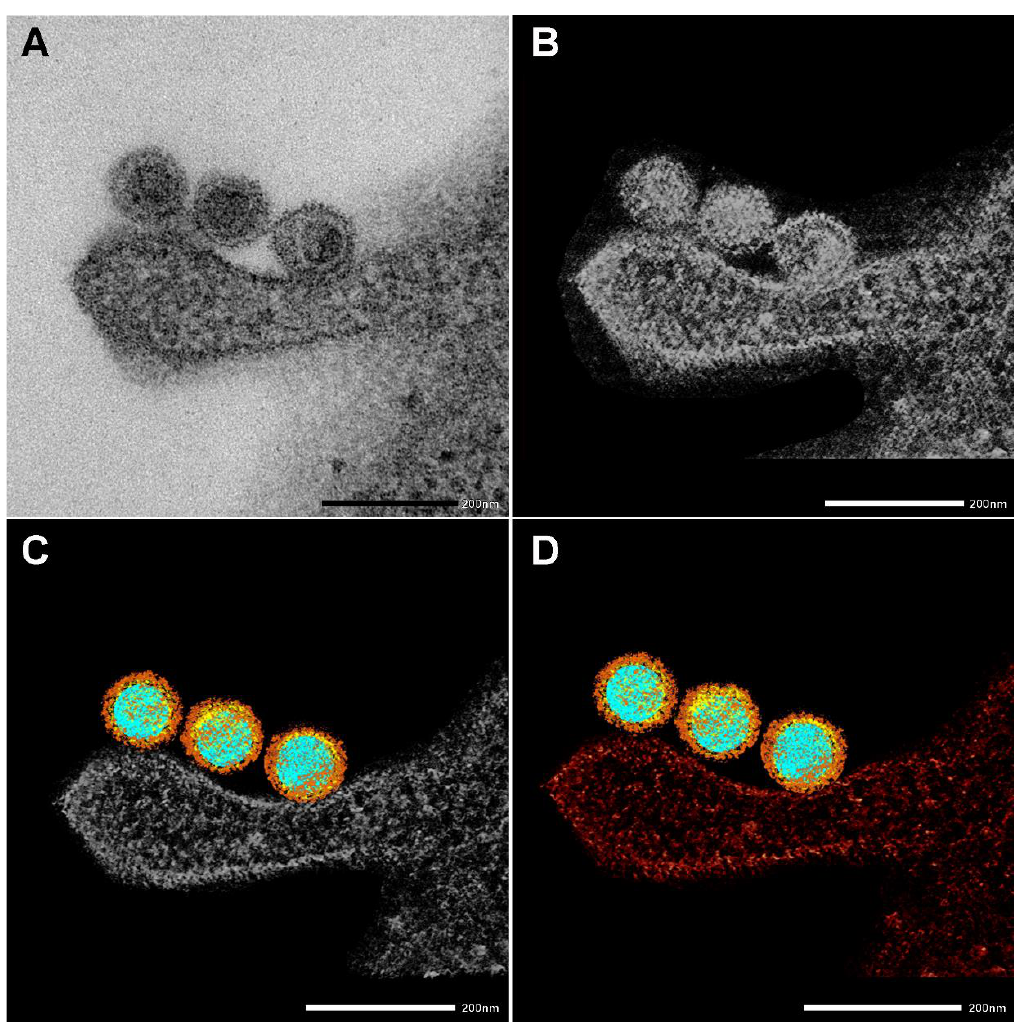
Figure 3. Creating a 3D electron tomography. ( A ) SARS-CoV-2 particles bound by an invading RAW macrophagen at 10 min of incubation at 37 °C. Scale bar 200 nm. ( B – D ) The images presented are utilized to create a 3D electron tomography. Regions of interest, such as nucleic acid (blue), nucleocapsid (yellow) spike proteins (brown), and the neighboring macrophage (red), were segmented manually.